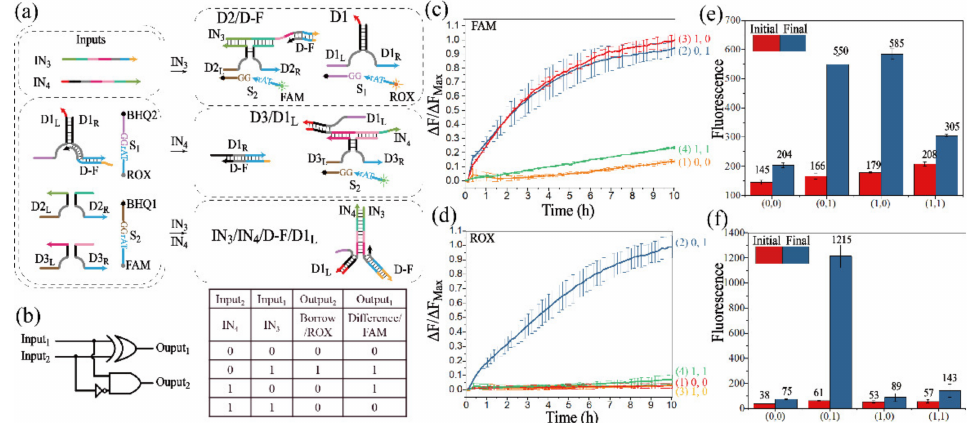
Figure 4. ( a ) Schematic diagram of the half-subtractor. ( b ) Truth table and logical operations of the half-subtractor. Time-dependent normalized fluorescence curves of the DIFFERENCE bit ( c ) and the BORROW bit ( d ). The fluorescence intensities are recorded every 10 min. (1) No input is added; (2) IN 3 is added; (3) IN 4 is added; (4) IN 3 and IN 4 are both added. The real fluorescence of the difference bit ( e ) and the borrow bit ( f ). The initial state: red columns, and the final state: blue